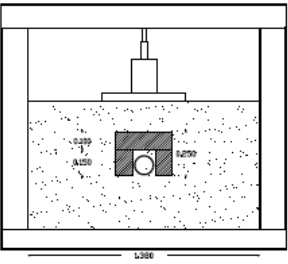
Figure 5. The experimental set up in case of pipe inside embedded EPS blocks culvert model